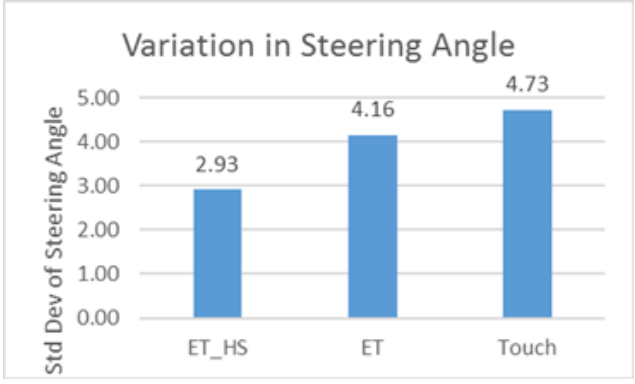
Figure 16. Comparing Driving Performance in terms of standard deviation of steering angle.